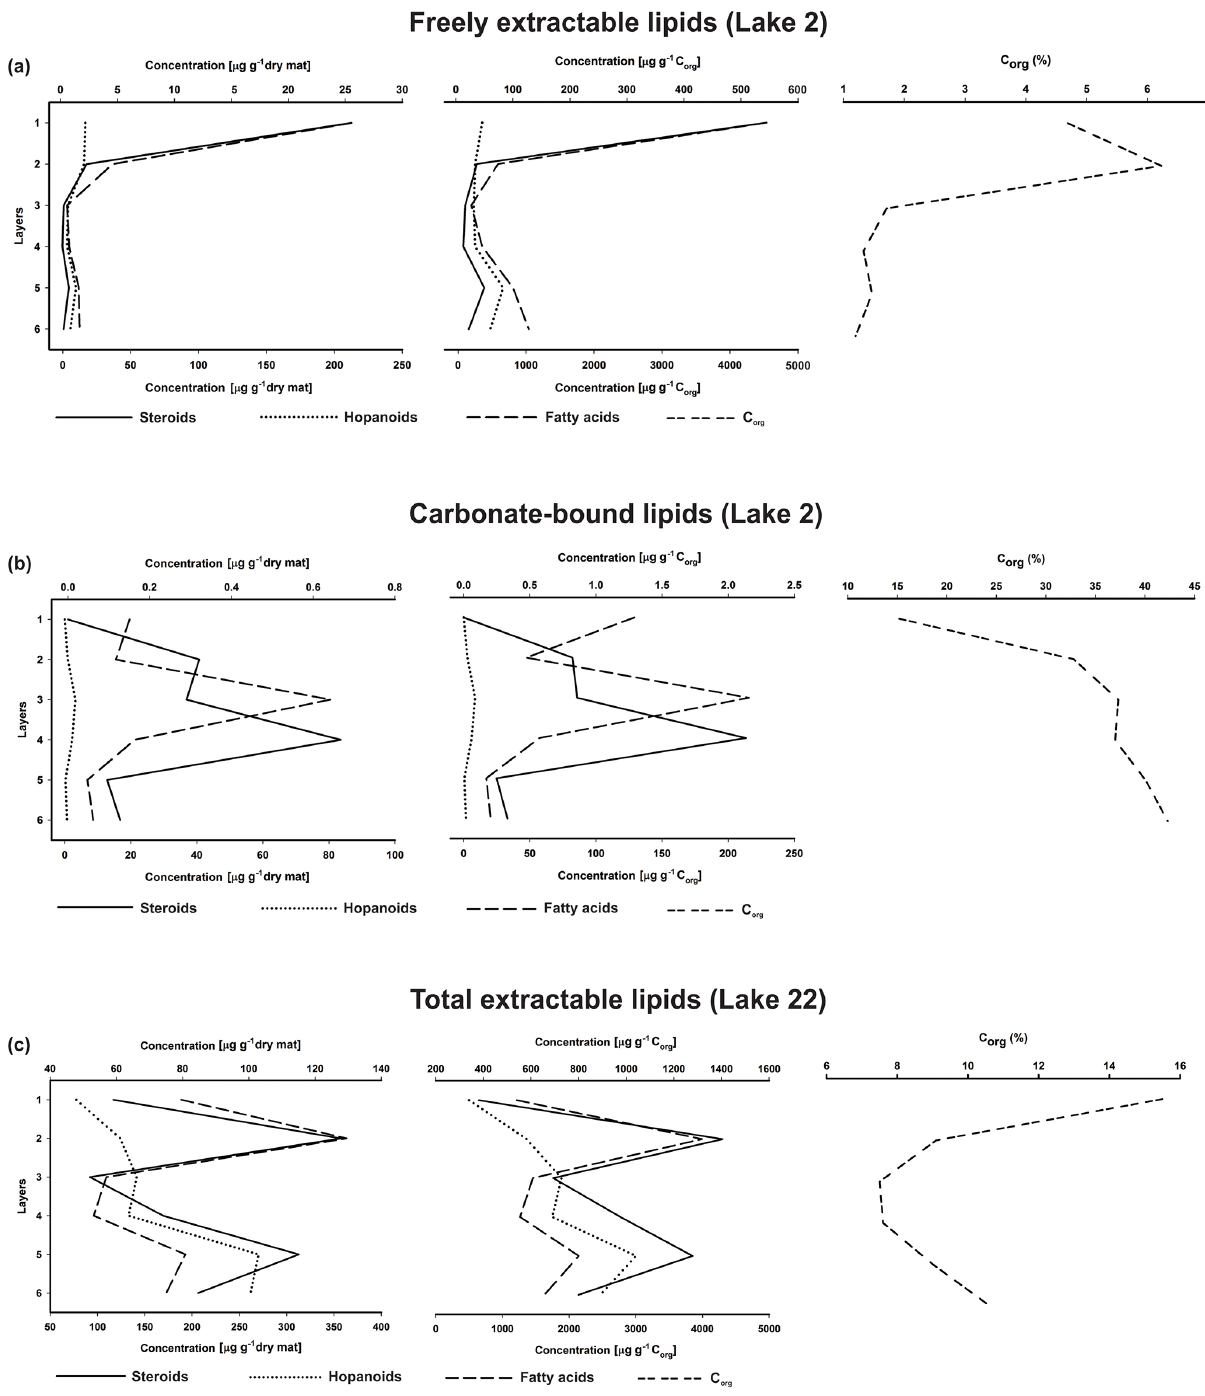
Figure 7. Depth distributions of steroids, hopanoids, and fatty acids (µgg − 1 dry mat; µgg − 1 C org ), and C org (wt%) in the microbial mat layers, (a) freely extractable lipids of the Lake 2 mat, (b) carbonate-bound lipids of the Lake 2 mat, and (c) total extractable lipids of the Lake 22 mat (Shen et al., 2018a) (upper x axes are applied to steroid concentrations and C org , while lower x axes are applied to hopanoids and fatty